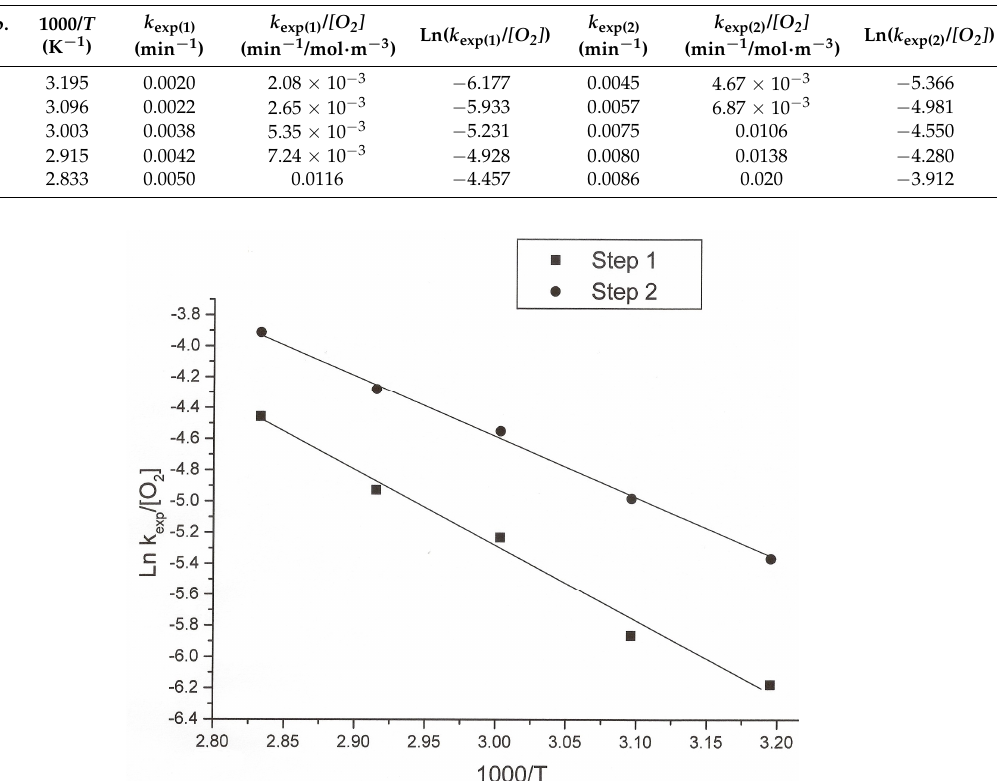
Figure 5. Apparent activation energy (E a ) for thiosulfate transformation (first step): 41 kJ · mol − 1 , and (second step): 33 kJ · mol − 1 .